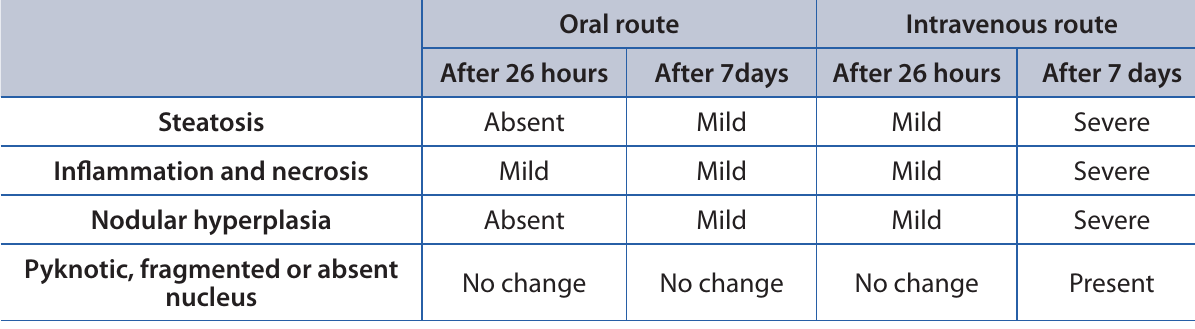
Table 3. Histopathological effect of DON on the liver after oral and intravenous